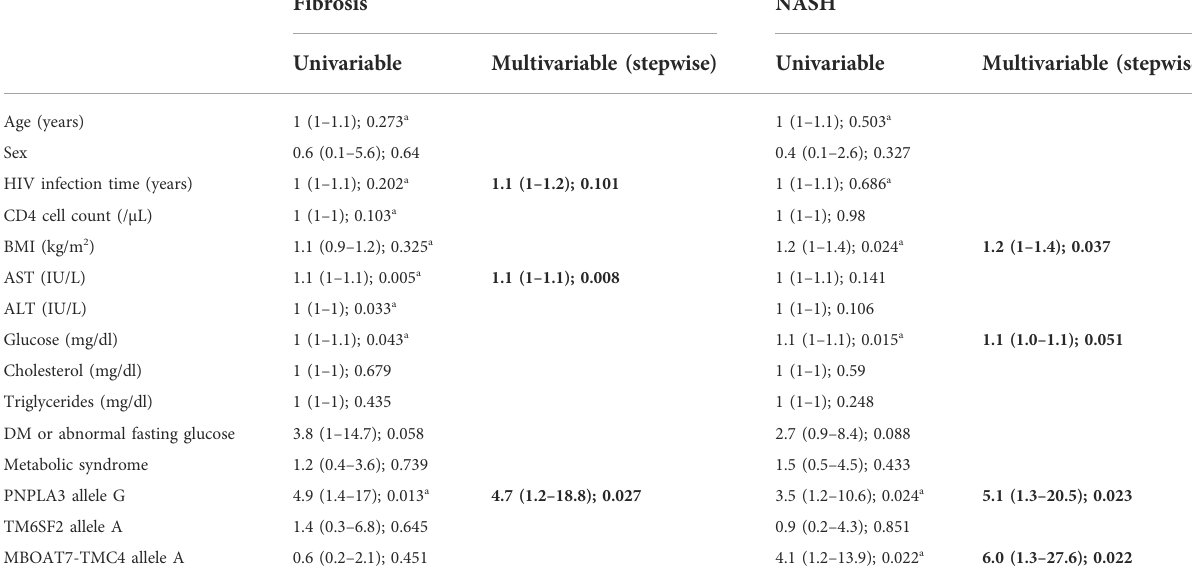
TABLE 3 Multivariate analysis for liver fi brosis and steatohepatitis. Fibrosis NASH Univariable Multivariable (stepwise) Univariable Multivariable